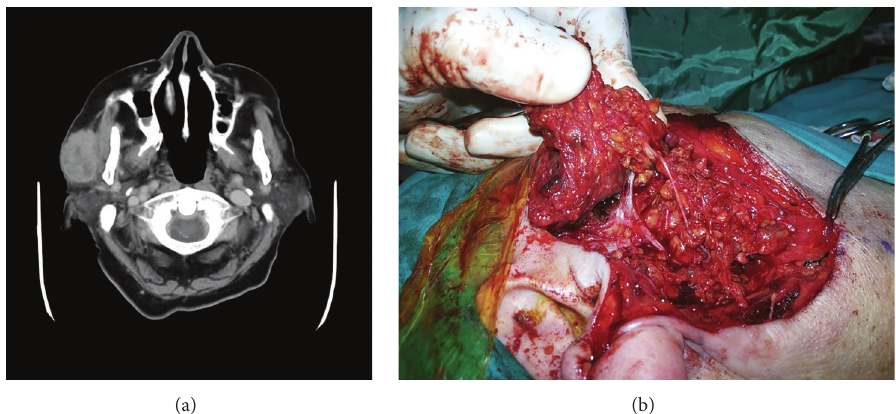
Figure 1: (a) Lobular-contoured solid mass in the anterior lobe of the right parotid gland (4 × 2.5 cm in size) in the patient’s computed tomography (CT). (b) The lesion invading temporozygomatic and buccal branches of the facial nerve and originating from the superficial lobe of the parotid gland.